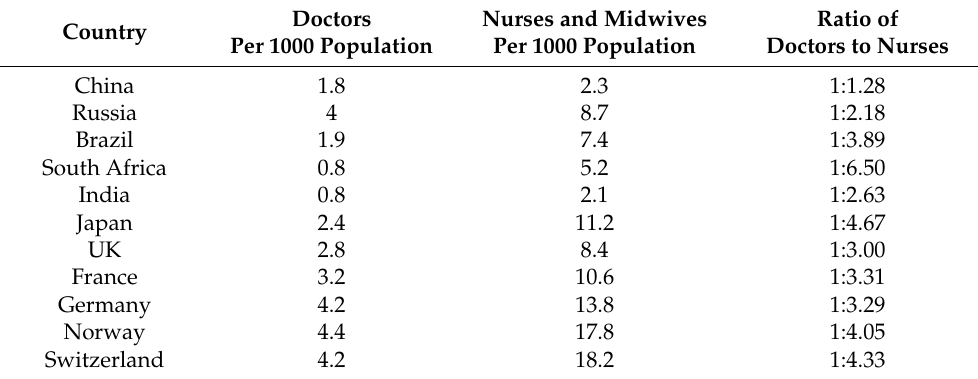
Figure 1. Number of public hospitals and private hospitals nationwide from 2010 to the end of November 2019. Note: The first case of new coronary pneumonia in China was discovered in Wuhan on 8 December 2019. In order to reflect the number of public and private hospitals in China before the outbreak, the latest phase of data uses the data at the end of November 2019. In order to reflect the monthly year-on-year changes, the data of other years are also used at the end of November. Data: National Health Commission of the PRC. Table 1. Healthcare staffing in BRICS and developed economies, 2007–2016.